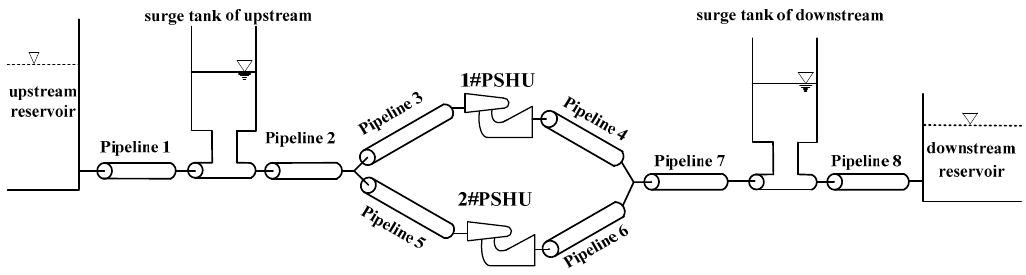
Figure 1. Structure of a ‘single tube-double unit’-type pumped storage hydro unit system.